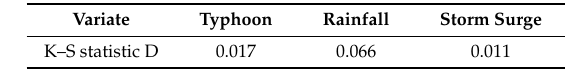
Table 5. Fitting results of marginal distribution functions. K–S, Kolmogorov–Smirnov.